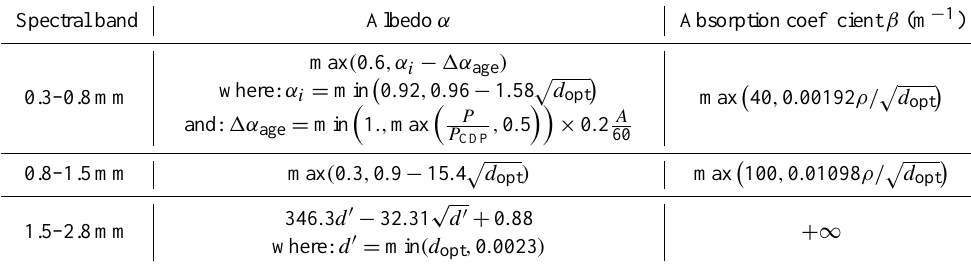
Table 4. Evolution of snow albedo and absorption coefficient for three spectral bands based on theoretical studies of Warren (1982). A is snow-surface age expressed in days and d opt (m) the optical grain diameter given by Eq. (13). The term P/P CDP represents the decreasing effect of ageing on the albedo with elevation ( P : mean pressure and P CDP :